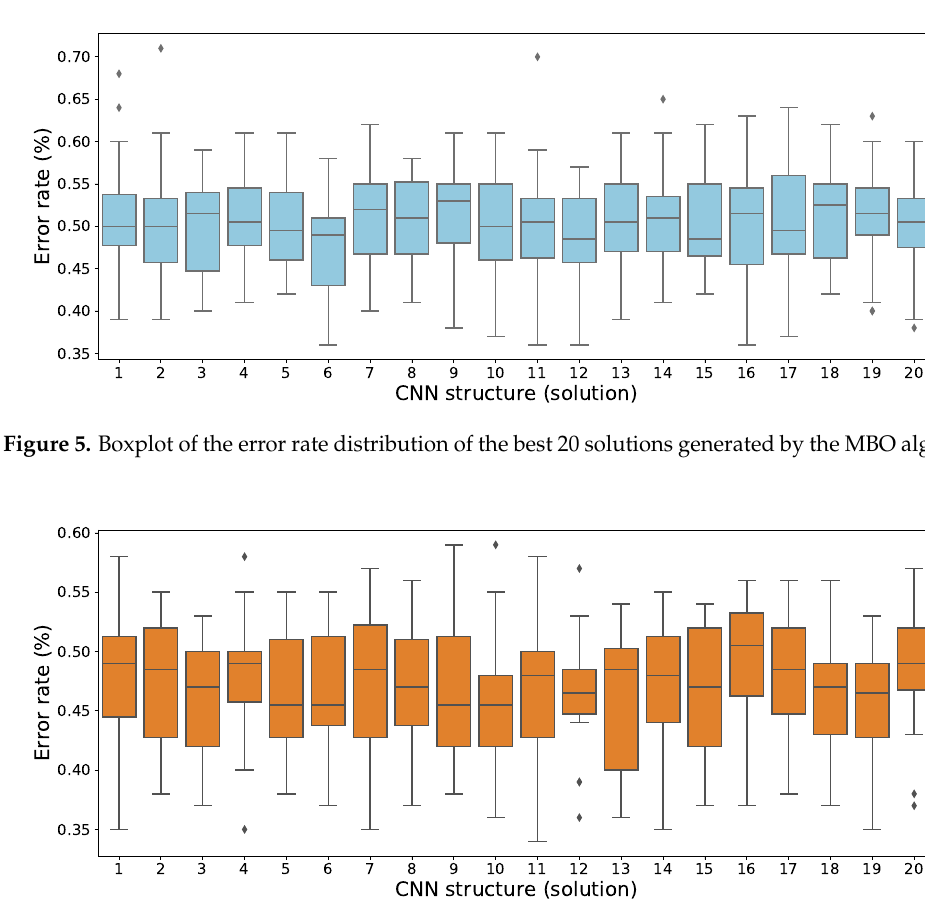
Figure 6. Boxplotoftheerrorratedistributionofthebest20solutionsgeneratedbytheMBO-ABCFEalgorithm. The minimum classification error rate of the 20 best CNN structure generated by the MBO algorithm ranged between 0.36 % and 0.5%, with a median value of 0.44%; on the other hand, the maximum classification error rate ranged between 0.45% and 0.71%, with a median value of 0.575%. In the case of the proposed MBO-ABCFE algorithm, the minimum classification error rate of the 20 best CNN structures ranged between 0.34% and 0.47%, with a median value of 0.415%, and the maximum classification error rate ranged between 0.39% and 0.59%, with a median value of 0.545%. The best architecture resulted in a 0.36% error rate on the test set. The optimized architecture consisted of two convolutional layers, the filter size in the first layer being 64 and in the second layer 128. The filter size was 5 × 5 in the first layer and in the second 3 × 3. The pooling layers’ size was 2 × 2 after each convolution. In the convolution layers, as well as the FC layers, the ReLU activation function was used. The architecture had only one full-connected layer before the classification layer, and it had 1024 hidden units. As regularization, only a dropout with probability 0.5 of keeping was selected. The batch size was 100, and the structure was trained by the adamax optimizer with a learning rate α = 10 − 3 . The best resulted architecture is depicted in Figure